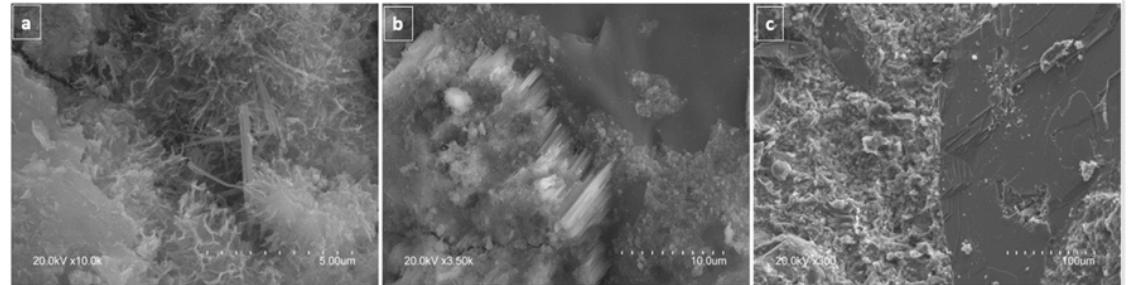
Figure 9. SEM micrographs of RACC: ( a ) calcium silicate hydrate gel honeycombing and ettringite needles; ( b ) column-like clusters of portlandite; ( c ) portlandite plates.